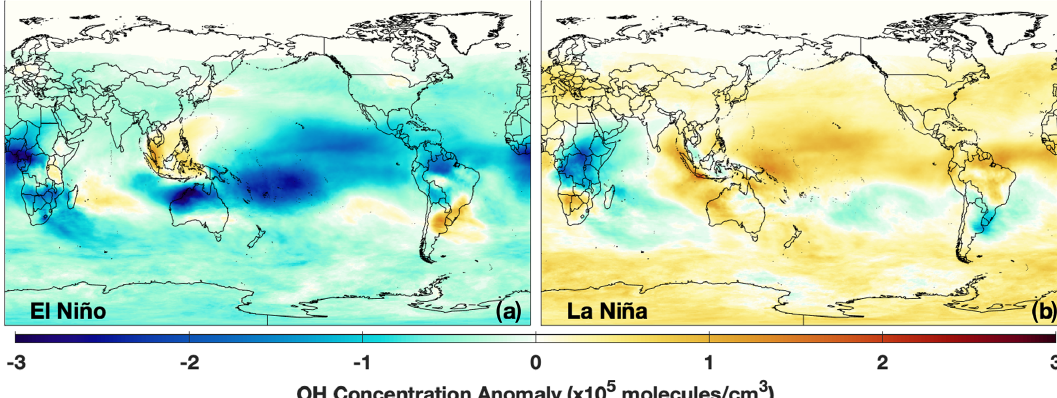
Figure 14. Same as Fig. 7 except for the